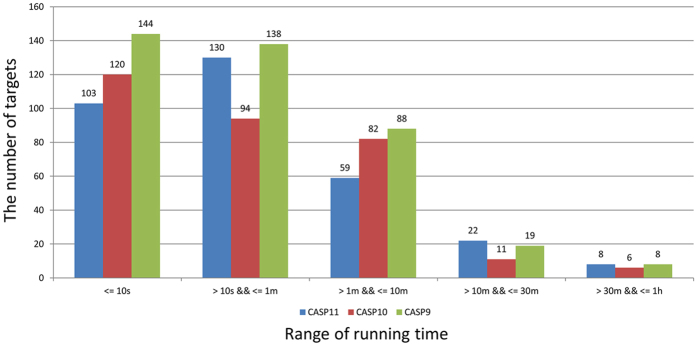
The number of targets in different ranges of running time on CASP9, CASP10, and CASP11 targets.92.83% of targets were modeled by MTMG within 10 minutes, and all the targets were modeled in an hour in the experiment.